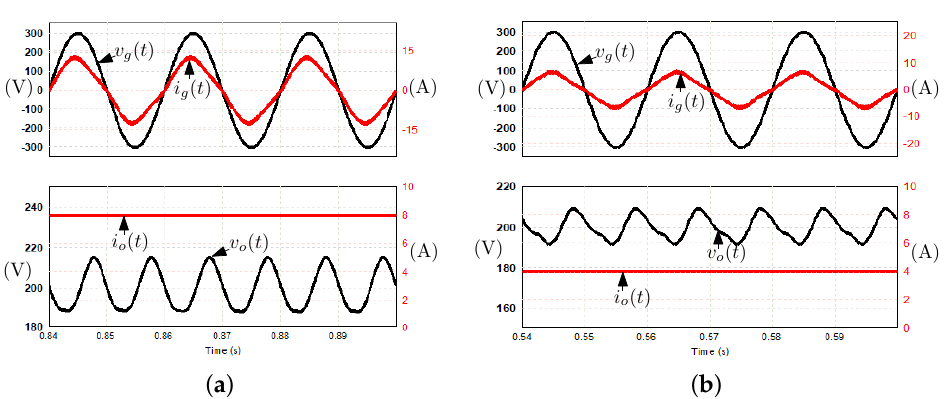
Figure 18. Steady state waveforms for buck mode of input voltage v g ( t ) , input current i L 1 ( t ) , output voltage v o ( t ) and the output current i o ( t ) with: ( a ) Full power. ( b ) Half power.